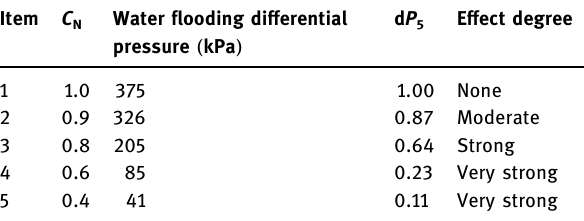
Table 5: Fracture plugging performance of polymer gel at di ff erent leak o ff degrees ( W f = 2 mm ) Item C N Water fl ooding di ff erential